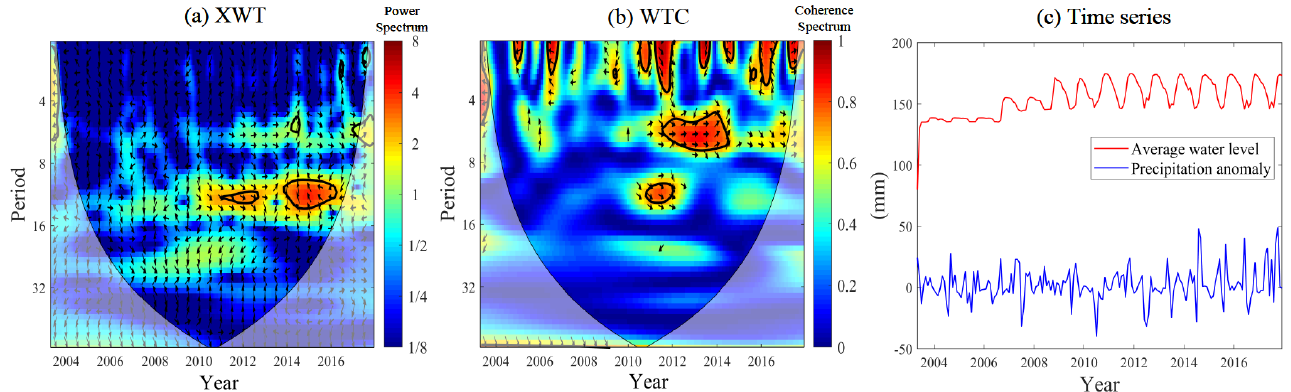
Figure 9. Wavelet coherence between precipitation anomaly and monthly average water level (( a ) cross-wavelet power between precipitation anomaly and monthly average water level; ( b ) corresponding wavelet coherence between precipitation anomaly and monthly average water level; ( c ) time series of precipitation anomaly and monthly average water level).